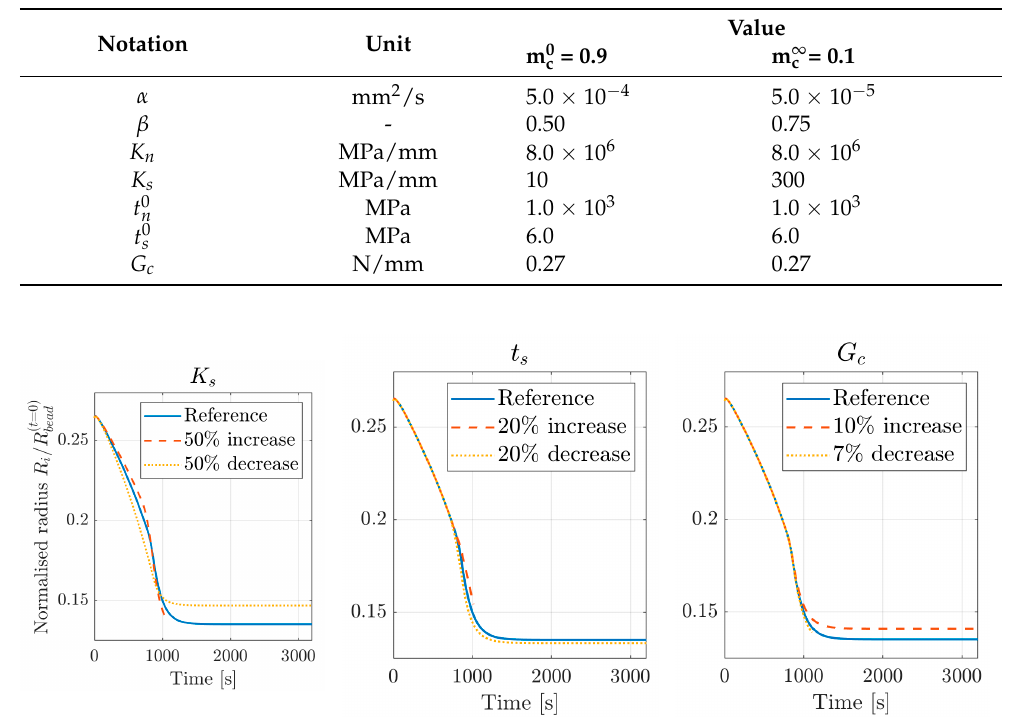
( b ) Figure 9. Simulation results for ( a ) bead and contact radii compared for reference simulations (as described in Section 3.1) and custom stiffness and exponential damage softening (as described in Section 2.4), and ( b ) a close-up of simulated contact radii compared to experimental data.